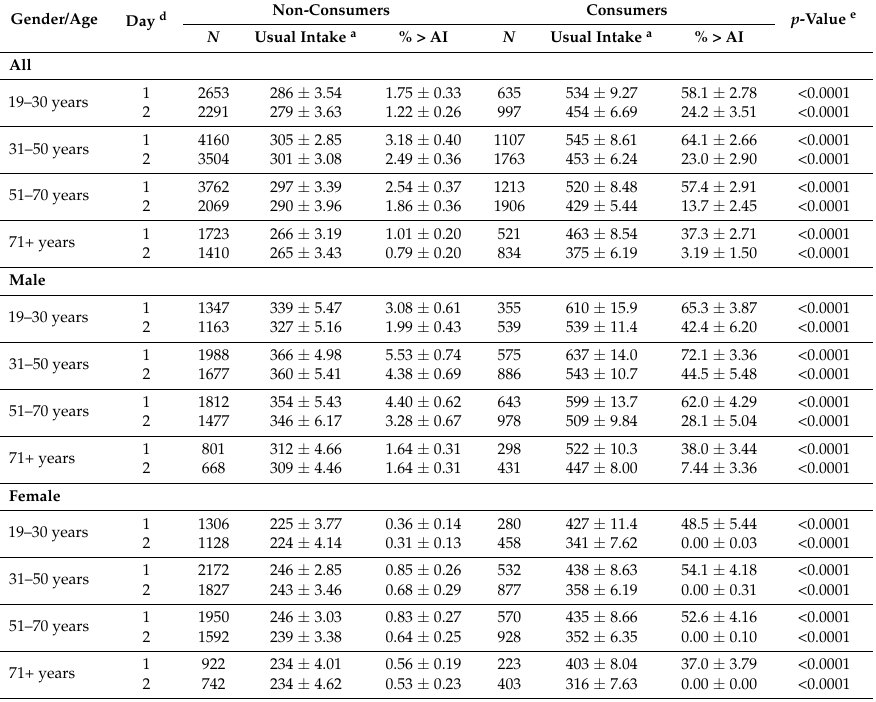
Table 3. Choline intakes among consumers vs. non-consumers of eggs a,b,c